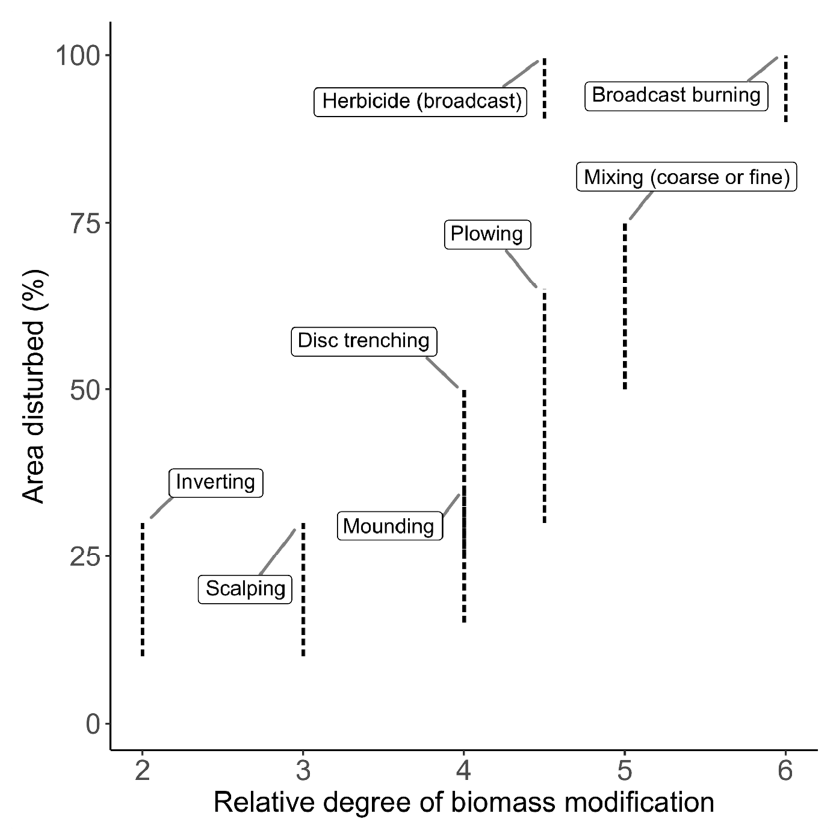
Figure 1. A two-dimensional framework for evaluation of site preparation disturbance-severity at the cutblock / stand level applied to eight site preparation techniques commonly used in boreal mixedwood ecosystems. The vertical axis is the percentage of the total area disturbed, with vertical bars representing the typical ranges of disturbed areas reported, and the horizontal axis is the degree of biomass modification (as per Table 1).